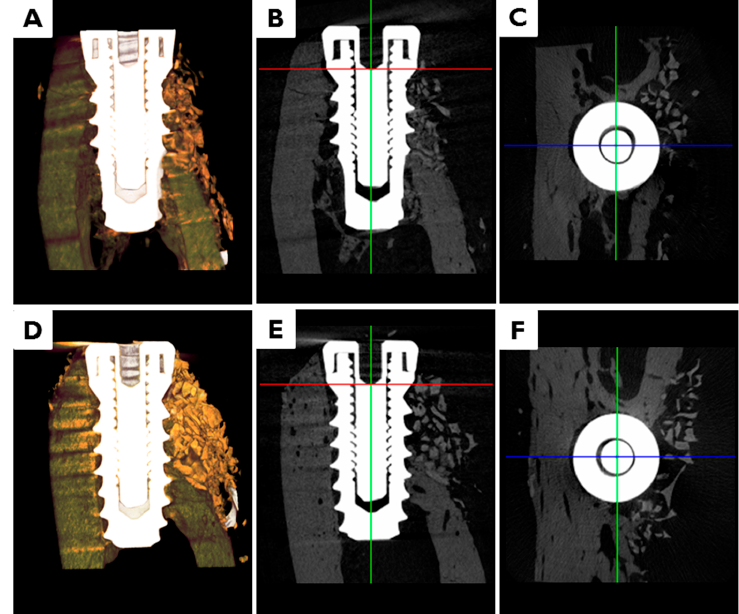
Figure 7. Micro-computed tomography ( μ CT) images. In animals transplanted with: CM ( A – C ); or EI-BCM ( D – F ), bone graft materials were observed in peri-implant dehiscence defect areas at eight weeks after surgery. ( A , D ) 3D images; ( B , E ) 3D reconstructed images of mesiodistal sections; and ( C , F ) 3D reconstructed images of occlusal sections. Table 1. Volumetric analysis within areas of interest (AOIs) ( n = 4).